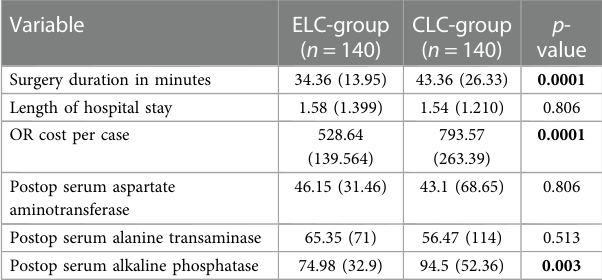
TABLE 1 Demographic and pre-operative data for each study group.